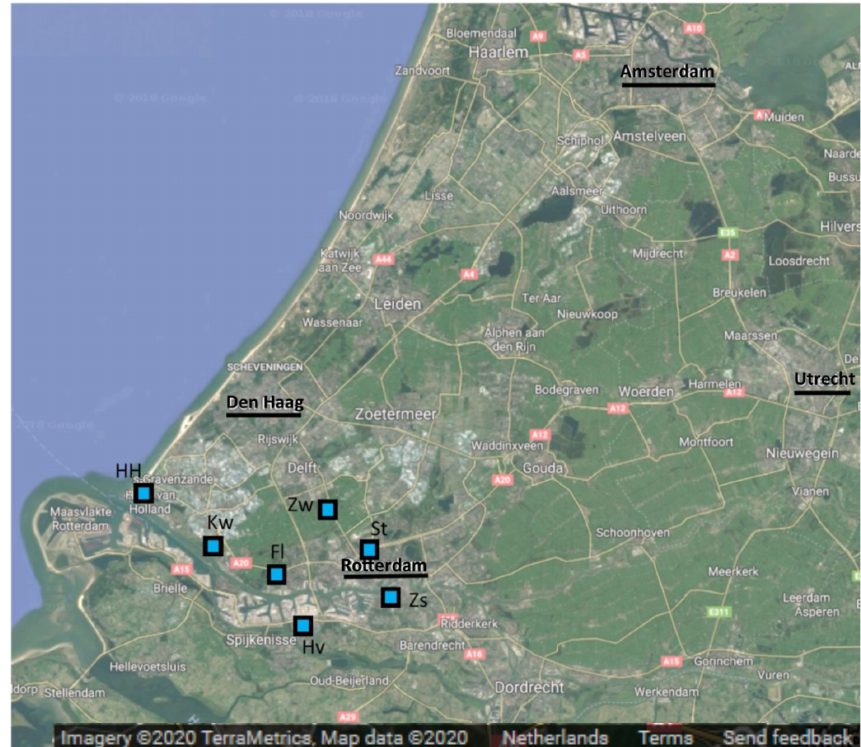
Figure 1. Map of the domain covered (Randstad area, the Netherlands) within this study, including major cities Amsterdam, Rotterdam, The Hague, and Utrecht (underlined). The squares show the locations of the measurement sites within the urban network configuration. The area of this domain is approximately 77km × 88km. Source: © Google Maps.